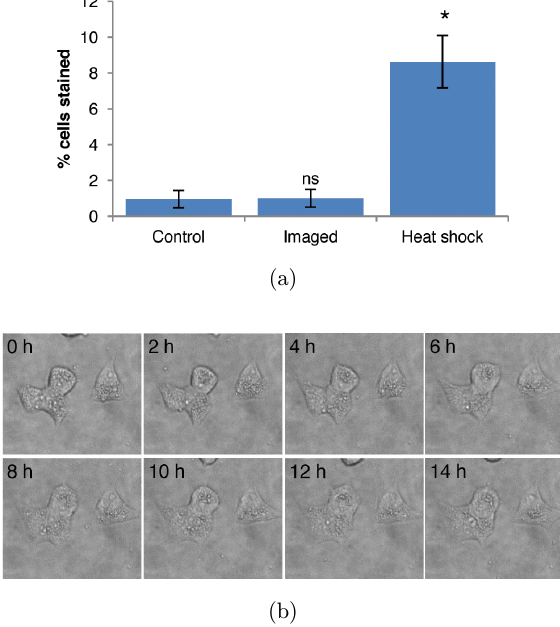
Fig. 4. Results of vital dye exclusion and morphology assays following auto°uorescence imaging experiments. (a) Results of erythrosin viability staining for adherent cells, illustrating that no signi¯cant di®erence is evident between control and imaged cell viability using this method. (b) Exemplar phase contrast images over a 16-h time course that were interleaved with NADH auto°uorescence FLIM acquisitions; the time elapsed since start of experiment is indicated in hours. There are no changes in cell morphology to indicate adverse e®ects caused by this extended imaging.